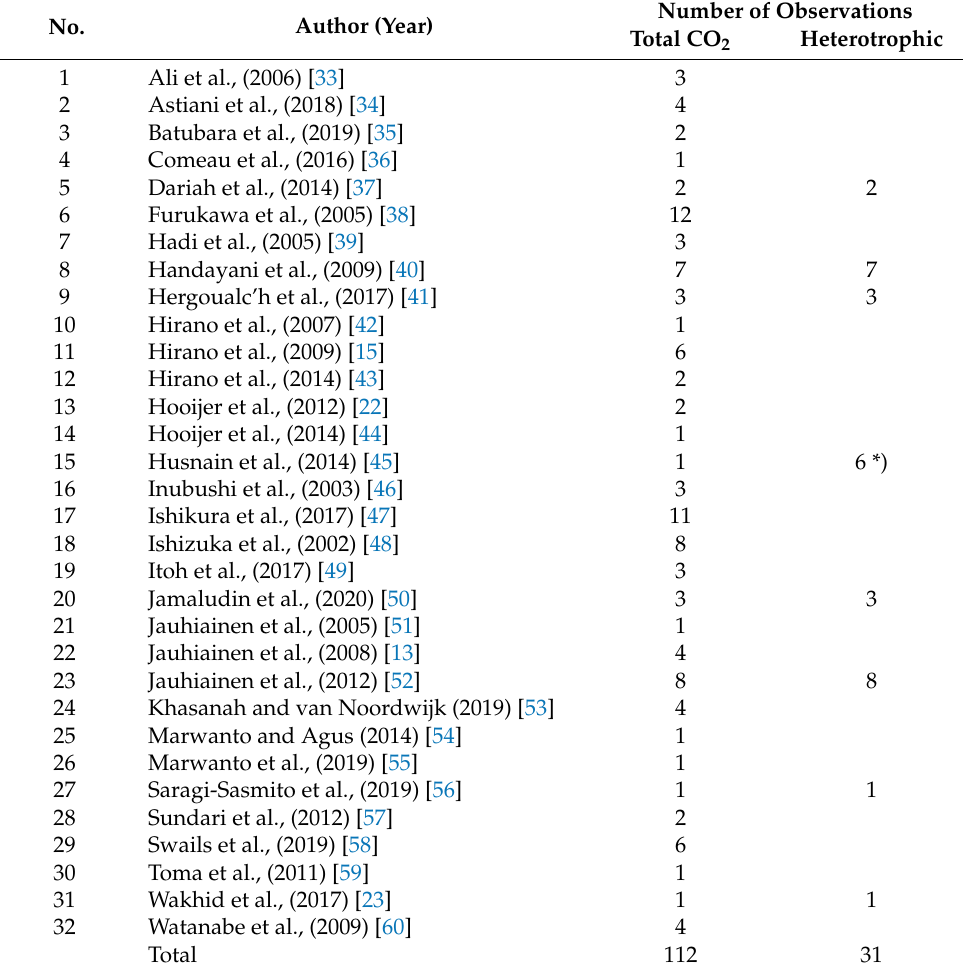
Table 1. List of the publications and number of observations for total CO 2 and heterotrophic emissions used in this meta-analysis